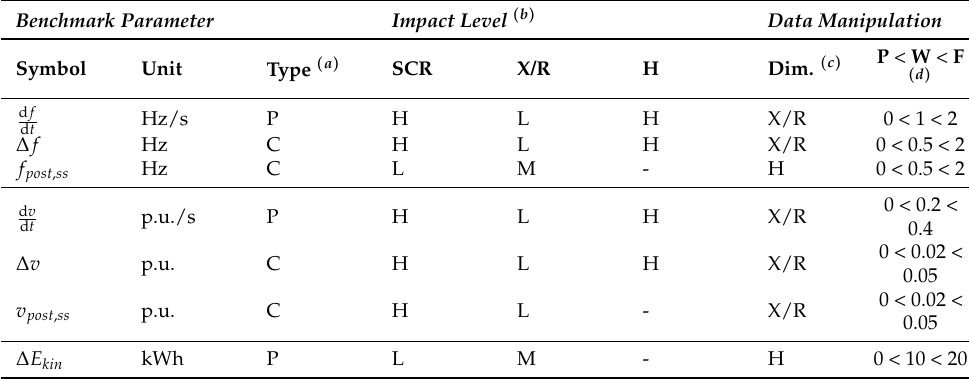
Table 5. Impacts of the compliance